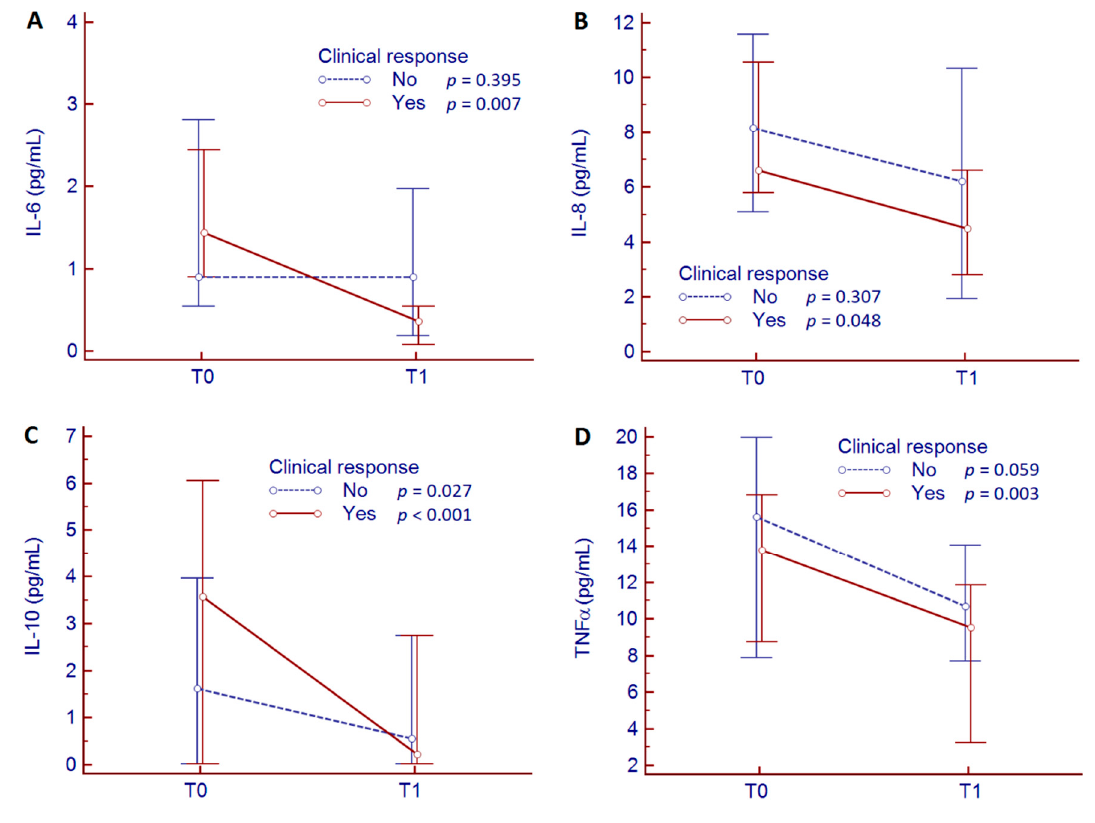
Figure 4. Reduction of IL-6 ( A ), IL-8 ( B ), IL-10 ( C ), and TNF α ( D ) values between baseline (T0) and 10 weeks (T1) of biologic therapy according to the response to treatment. T0, baseline; T1, 10 weeks.